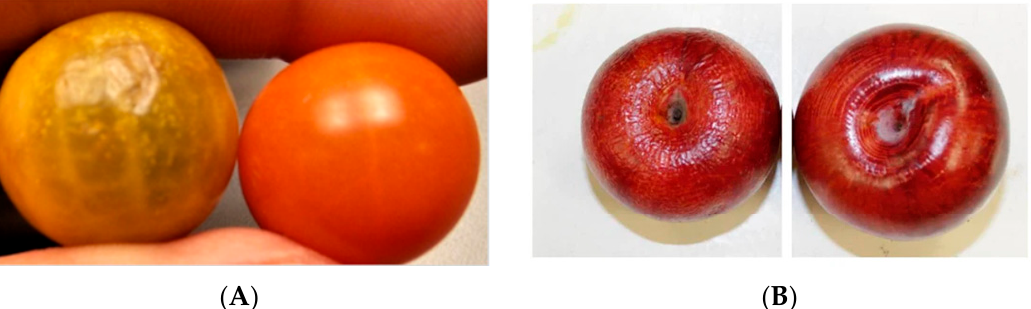
Figure 4. ( A ), Surface pitting of cherry tomatoes after 3 weeks at 2.5 ◦ C (followed by 1 week at 20 ◦ C) (left) compared to control (12.5 ◦ C for 3 weeks, followed by 1 week at 20 ◦ C) (right) [26]. ( B ), shrivelled plum (left) after five weeks at − 0.5 ◦ C (followed by 20 days at 20 ◦ C) compared with control samples (right) (same storage conditions but with an edible coating to avoid water losses that occur in the storage rooms due to increase product transpiration due to the airflow from evaporators) [27].